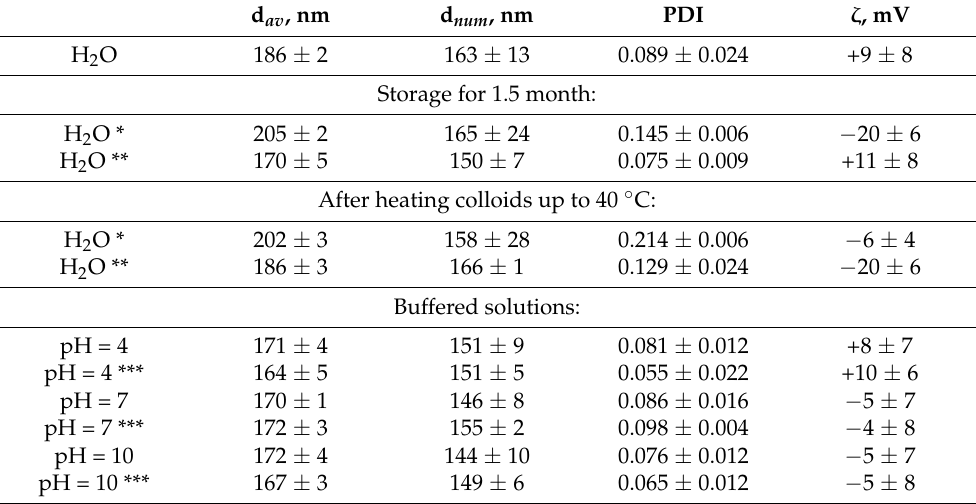
Table 1. Average diameter (d av ) and diameter values evaluated through the size distribution by number (d num ) measured by DLS, polydispersity indices (PDI) and electrokinetic potentials ( ζ ) of F-127-Cu 2 I 2 L 3 nanoparticles in pure water and buffered solutions. d av , nm d num , nm PDI ζ , mV Storage for 1.5